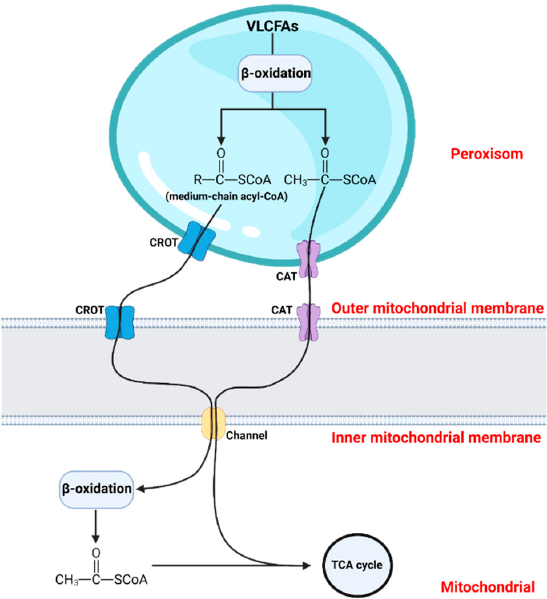
Figure 7. The transfer of fatty acids from peroxisomes to mitochondria. With the continuous emergence of new technologies (such as employing omics) and the expansion of research fields [30,35,133], this is indeed an exciting time to comprehensively explore the peroxisome itself and its β -oxidation mechanism, a research hotspot with plenty of opportunities and challenges ahead. The converging green arrow lines in the figure indicate the biogenesis of the peroxi- some, and the red arrow lines indicate that when one side of the peroxisome/mitochondrion undergoes oxidative damage/other damage, the other side performs functional compensa- tion. The black arrow lines represent normal material transport.